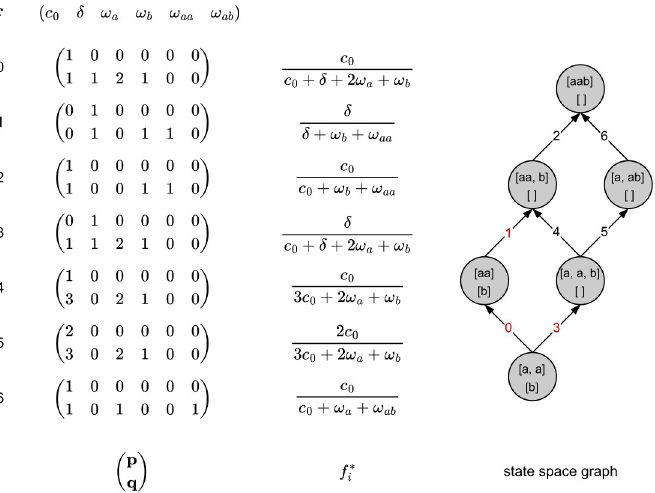
Fig 1. Coalescent state space graph for two populations A and B with 2 and 1 unphased sample(s), respectively. Each node in the graph is labeled by the lineages present in each population as indicated by the square brackets ( O : A top, O B : bottom). The demographic model assumes a single mass migration event from population B to A back in time. Vector r consists of the rates of all possible events: coalescence ( c 0 ) in population A , a dummy variable δ associated with the mass migration (see Discrete events), and a dummy variable ω for each possible branch type. The Laplace k transform associated with edge i , f ? , can be retrieved as the ratio of the dotproduct of p and q with r . Red indices on the i graph indicate edges associated with an equation containing δ . Edges 1 and 3 represent a mass migration event, moving all lineages from B to A . All other transitions represent coalescence events. All paths can be described by enumerating the indices of the associated matrices: P ¼ ðð 0 ; 1 ; 2 Þ ; ð 3 ; 4 ; 2 Þ ; ð 3 ; 5 ; 6 ÞÞ .